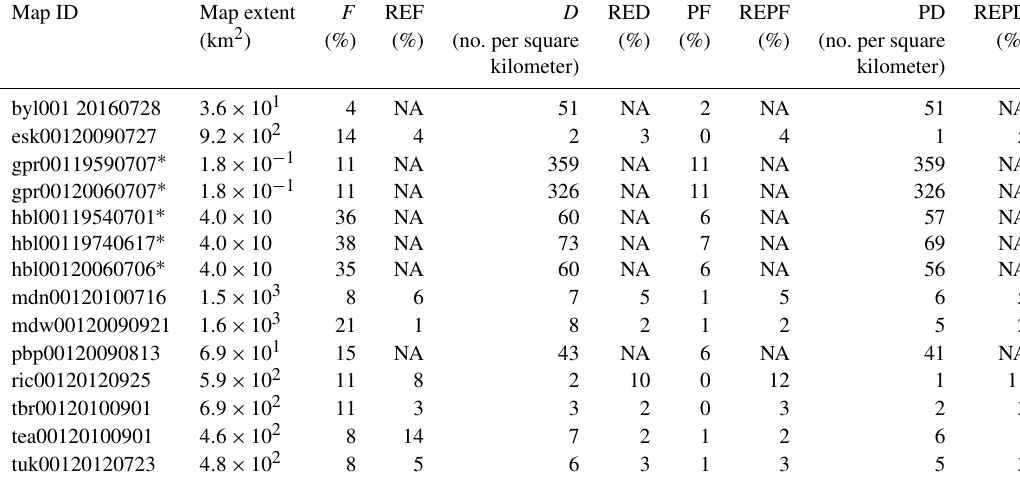
Table E2. Areal fraction and density per waterbody map in Canada. Map IDs with an asterisk were not used for extrapolation. F : areal fraction of waterbodies from 1 . 0 × 10 2 to 1 . 0 × 10 6 m 2 in size; REF: relative error of fraction for map subsets of 10km × 10km; D : waterbody density per square kilometer; RED: relative error of density; PF: pond areal fraction for waterbodies from 1 . 0 × 10 2 m 2 to smaller than 1 . 0 × 10 4 m 2 ; REPF: relative error of pond fraction; PD: pond density; REPD: relative error of pond